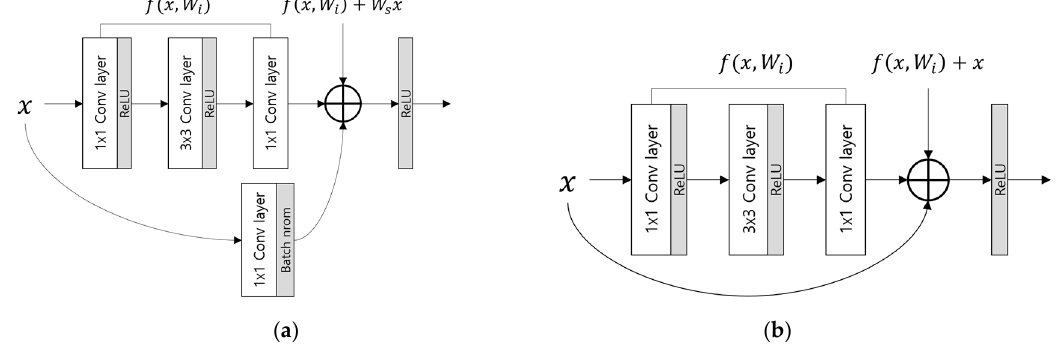
Figure 4. Examples of processes which involve short-cuts and identity mapping. ( a ) A process in which a 1 × 1 convolution (Conv) is used and the image size is adjusted to adjust the feature map channel when first starting to change the feature map size when processing each residual block. ( b ) A process that uses identity mapping when repeating the other residual blocks. In ( a ) and ( b ), rectified linear unit (ReLU) and batch normalization layer (batch norm) are included.